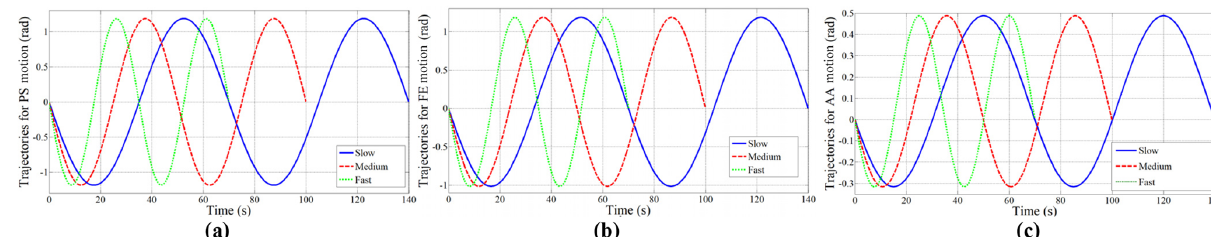
Figure 14. The trajectories with different velocity levels for PS, FE and AA motions.